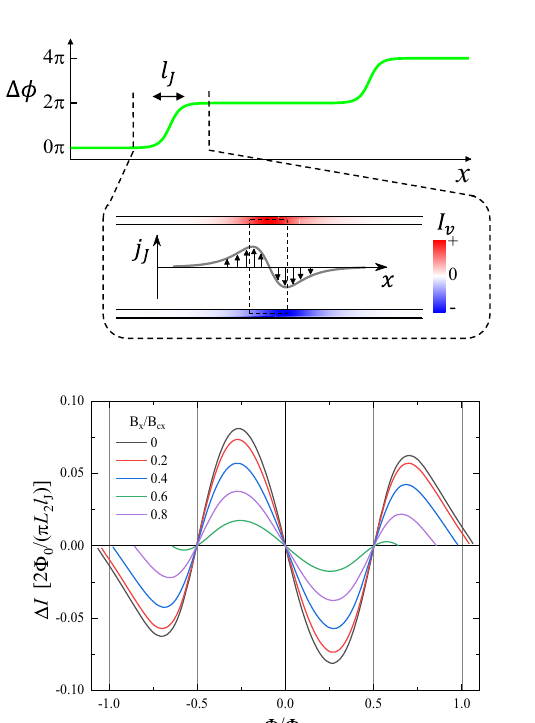
Fig. 3 | NRC in an asymmetric superconducting loop. a An average switching current for positive h I + sw i and negative h I (cid:1) sw i sweeps, non-reciprocal difference i + h I (cid:1) i and an average of all sweeps 〈 I sw 〉 plotted as a function of out-of- Δ I = h I + sw sw plane magnetic fi eld B o for a loop shown in the insert in ( b ). Note that 〈 I sw 〉 is